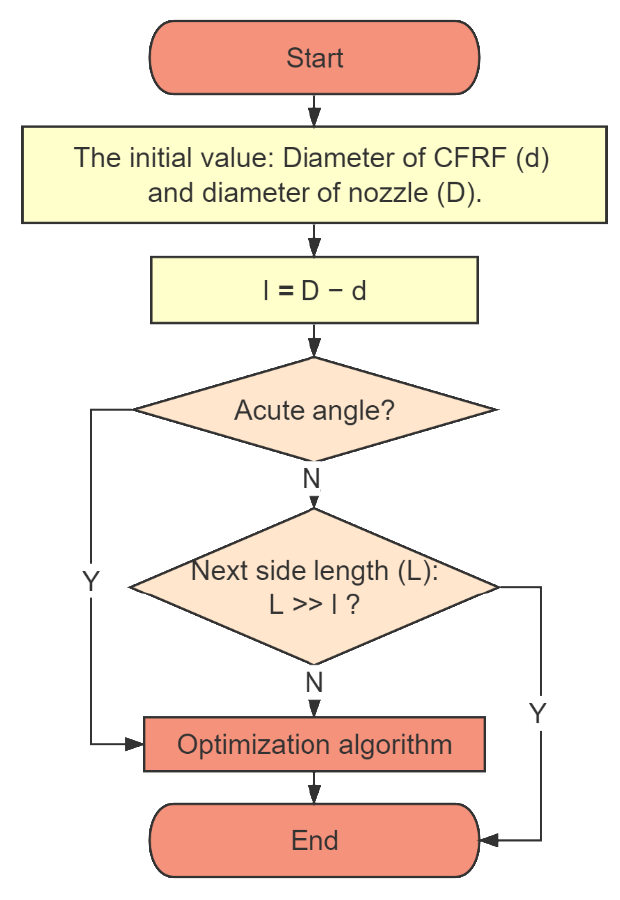
Figure 7. Flowchart of the corner optimization algorithm.